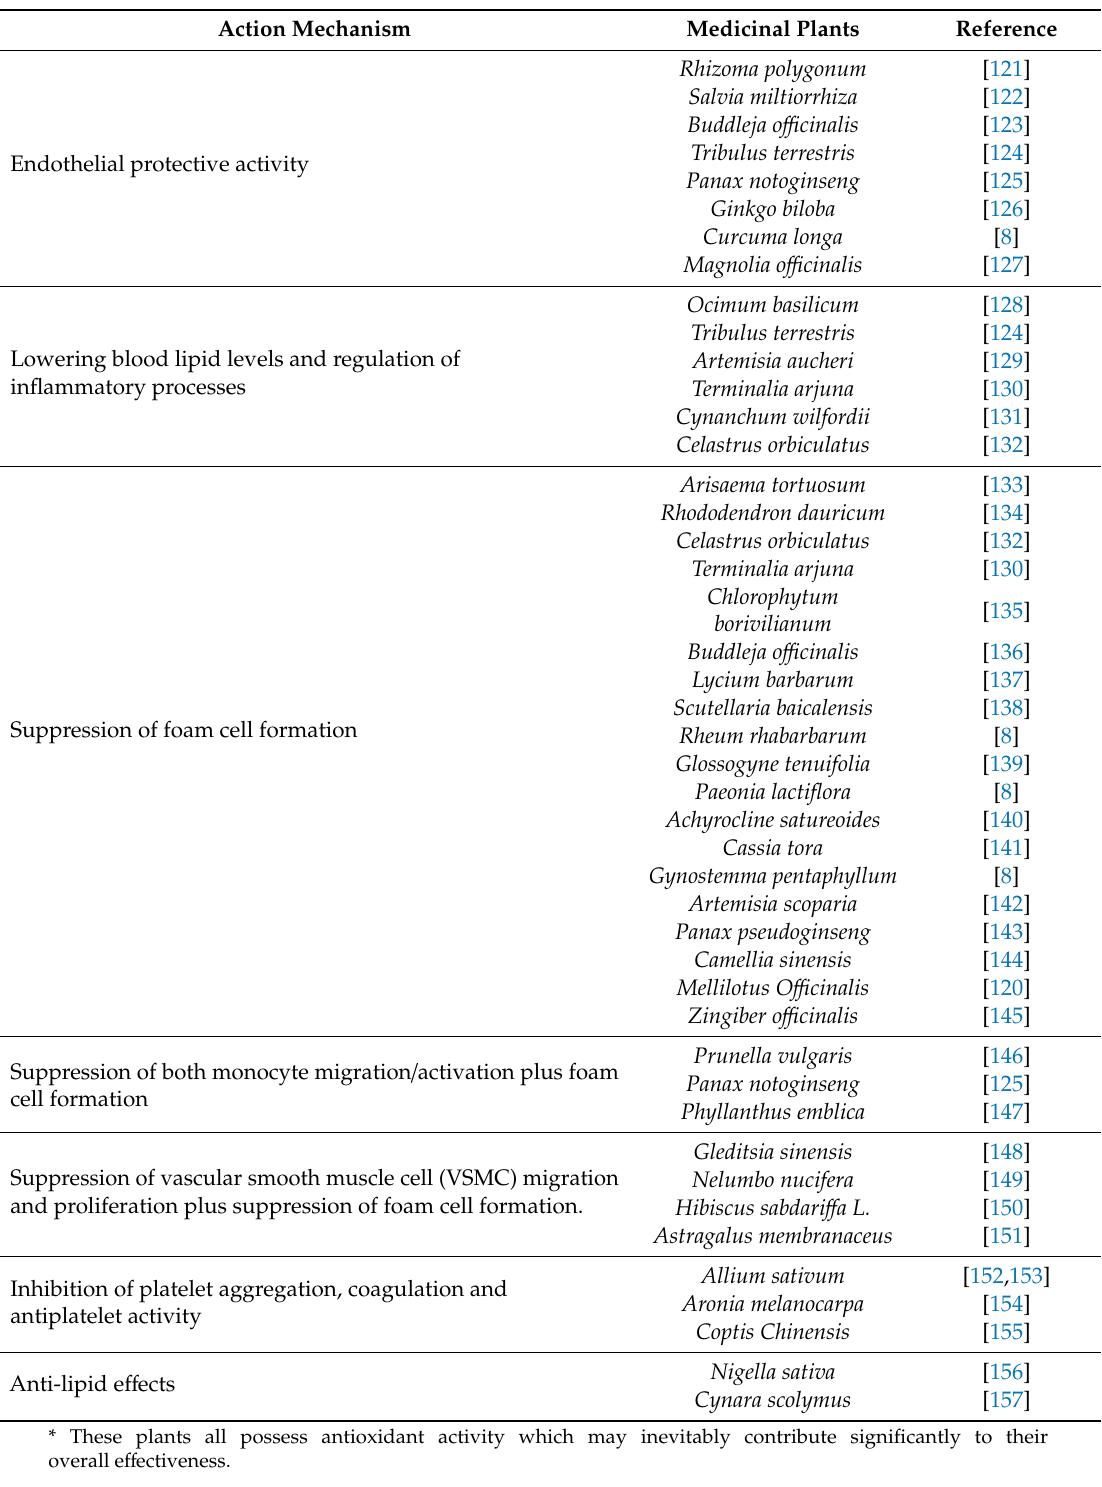
Table 2. Non-antioxidant potential mechanisms in medicinal plants with antioxidant e ff ect